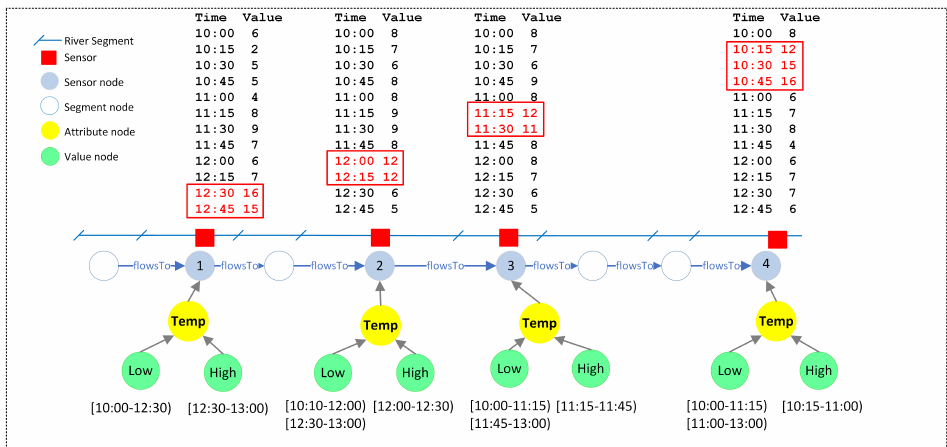
Figure 8. River Network Backwards Flow Path for Temperature = High